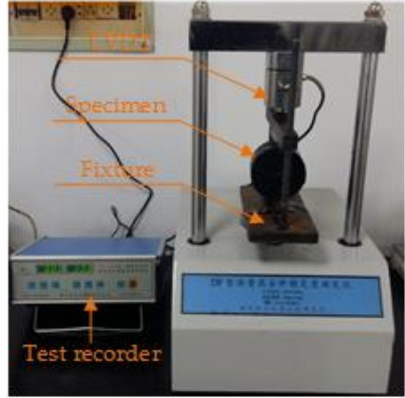
Figure 6. The freeze-thaw splitting test in this paper.